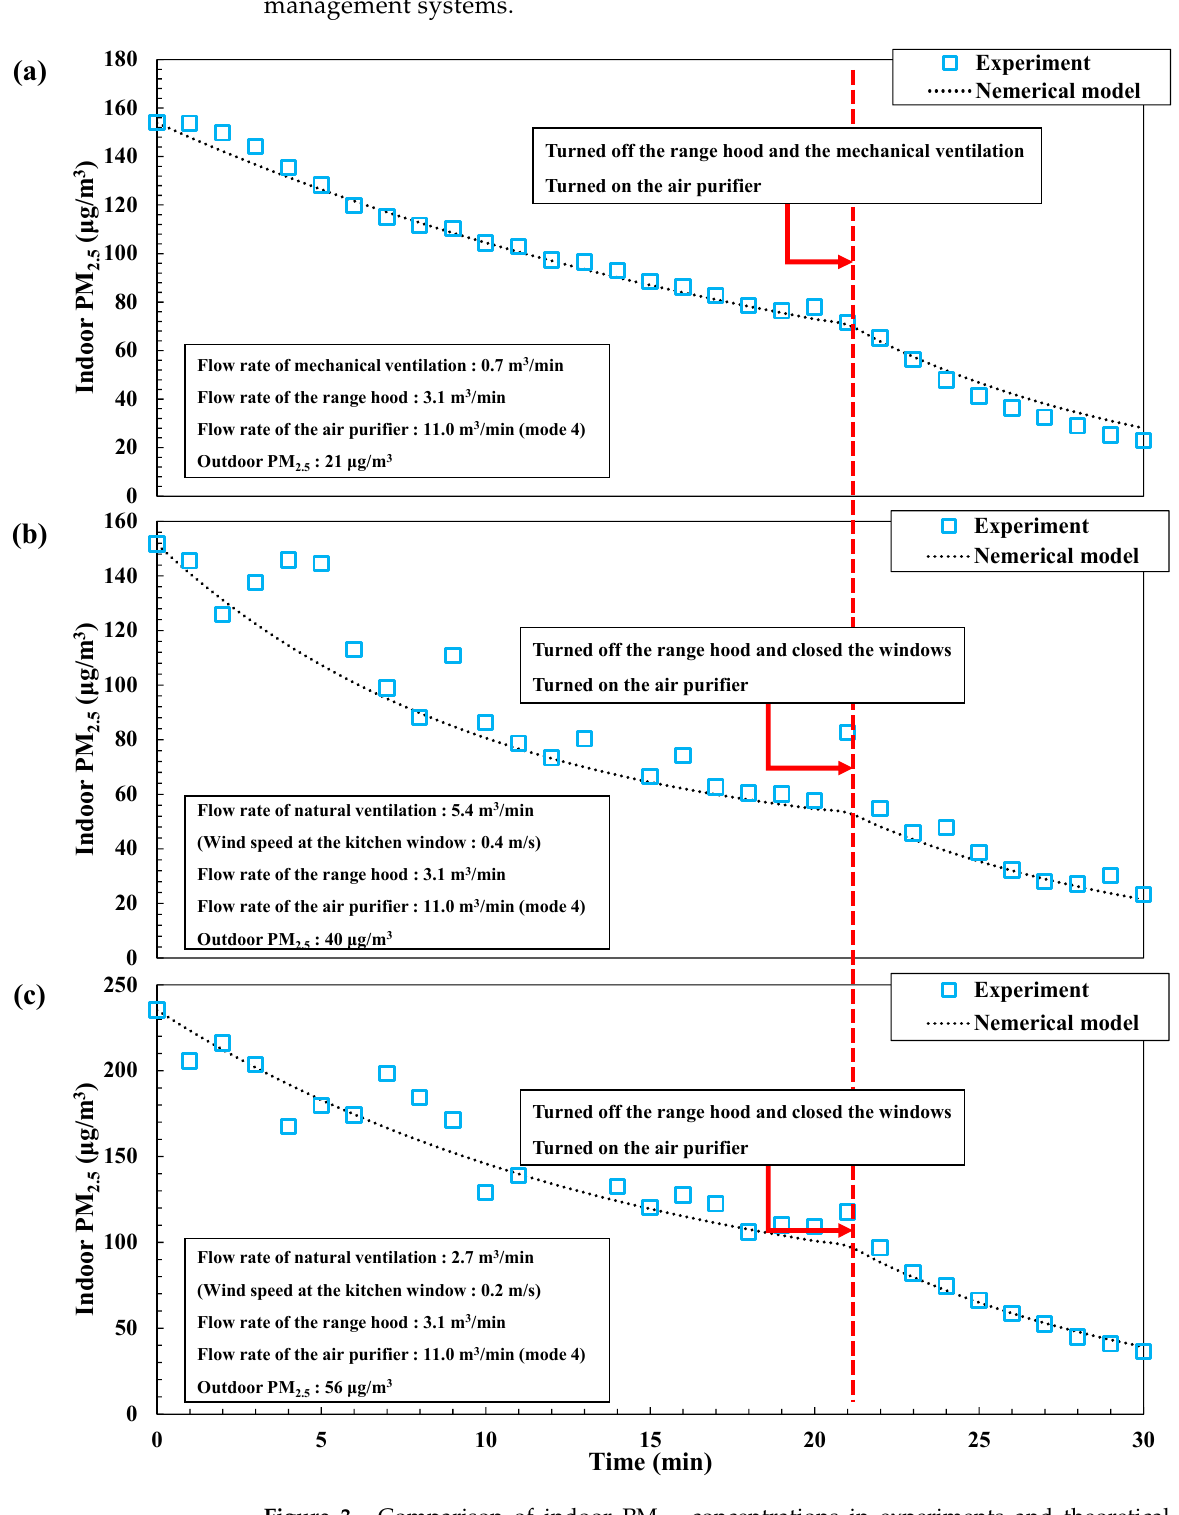
Figure 3. Comparison of indoor PM 2.5 concentrations in experiments and theoretical model. ( a ) Mechanical ventilation + range hood + air purifier. ( b ) Natural ventilation (0.4 m/s) + range hood + air purifier. ( c ) Natural ventilation (0.2 m/s) + range hood + air purifier.